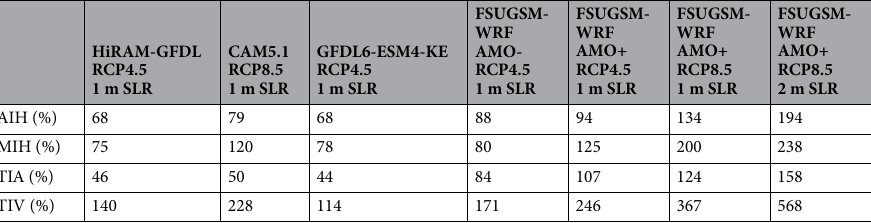
Table 2. Percent increase of inundation metrics from current climate to 2100 for four different models. These values are calculated as follows: Rate of increase of X ( % ) = ( X 2100 − avg ( X )/ avg ( X 2000 ) .